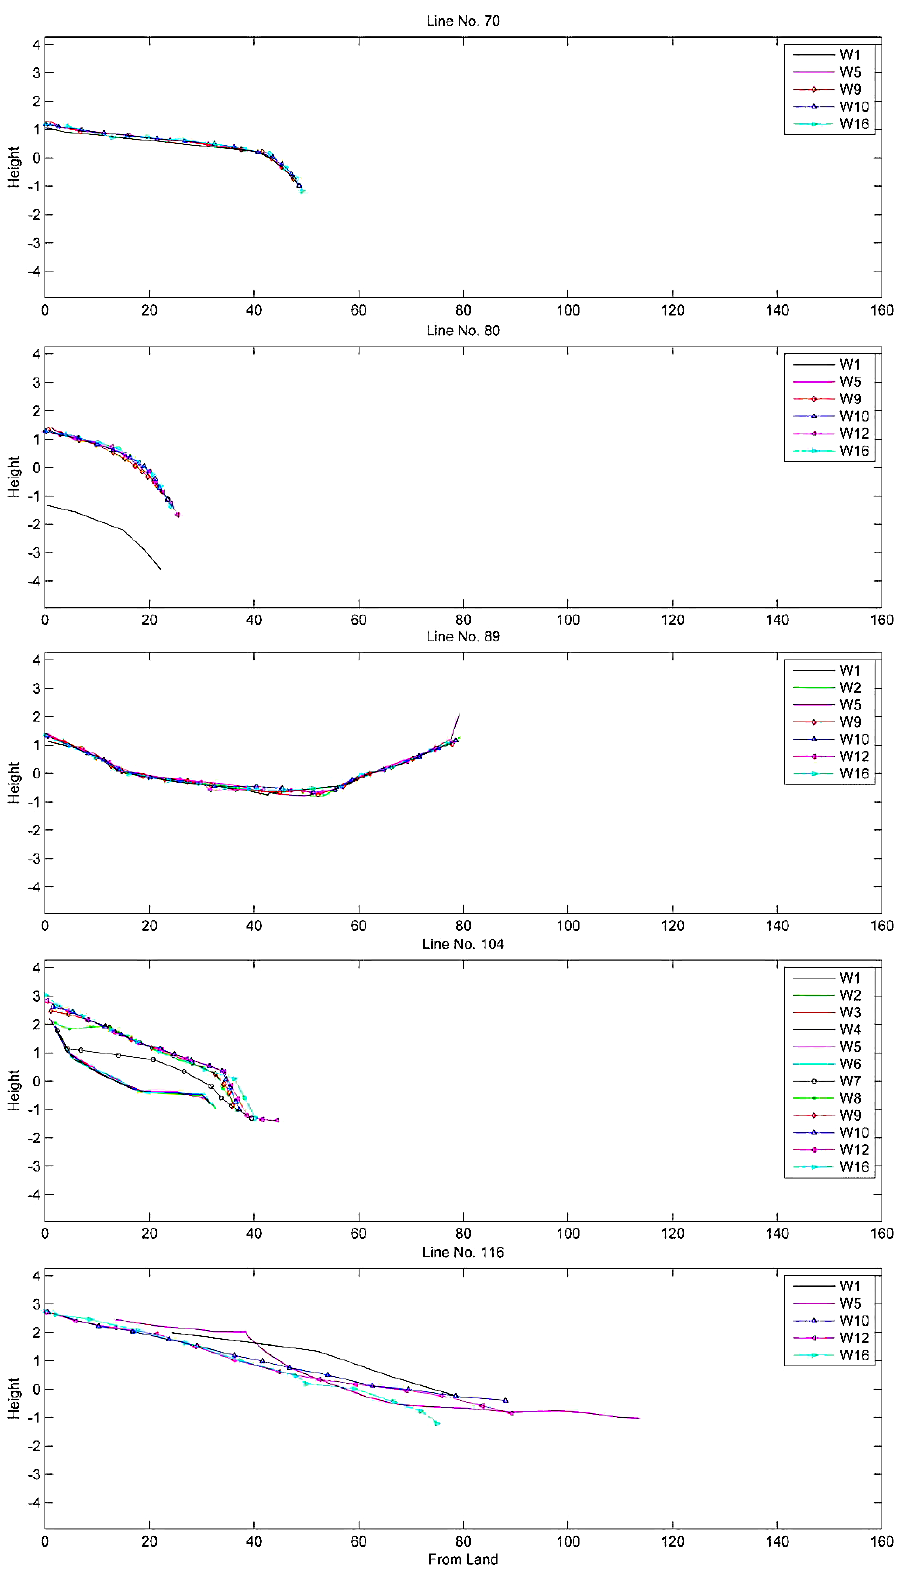
Fig. 9. Survey of the beach profile evolution for Line no. 70, 80, 89, 104 and 116. (All dimensions in